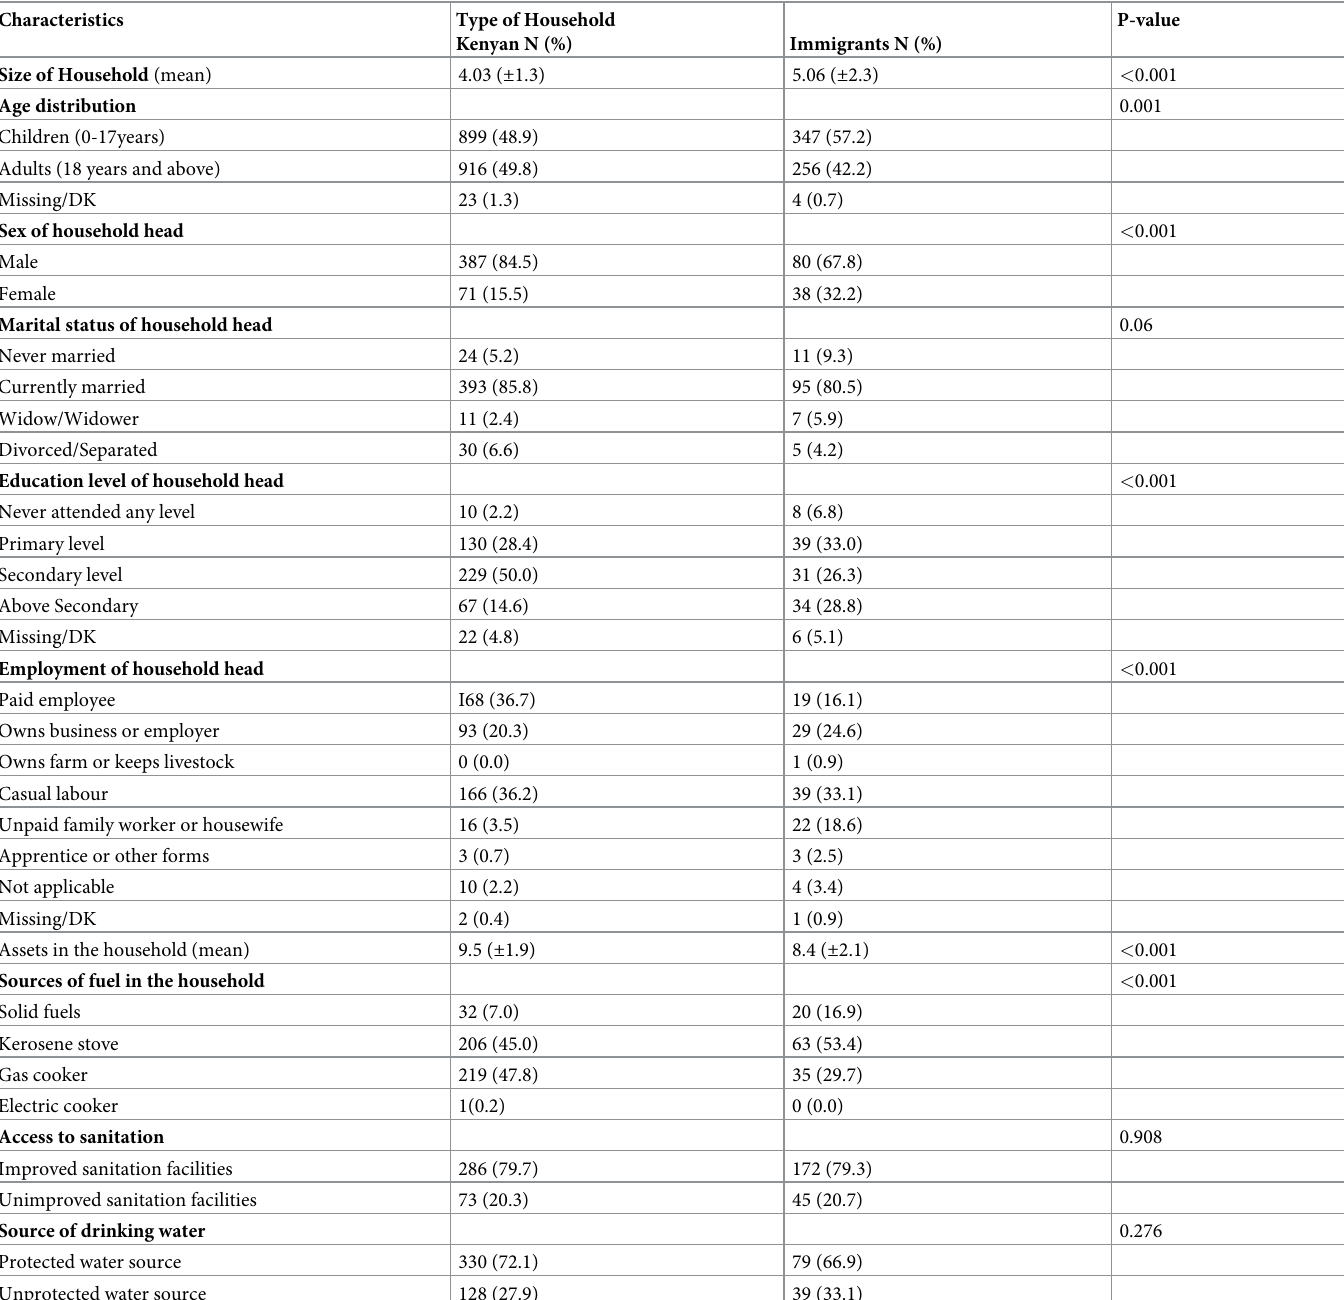
Table 1. Socio-demographic and household characteristics of study participants.